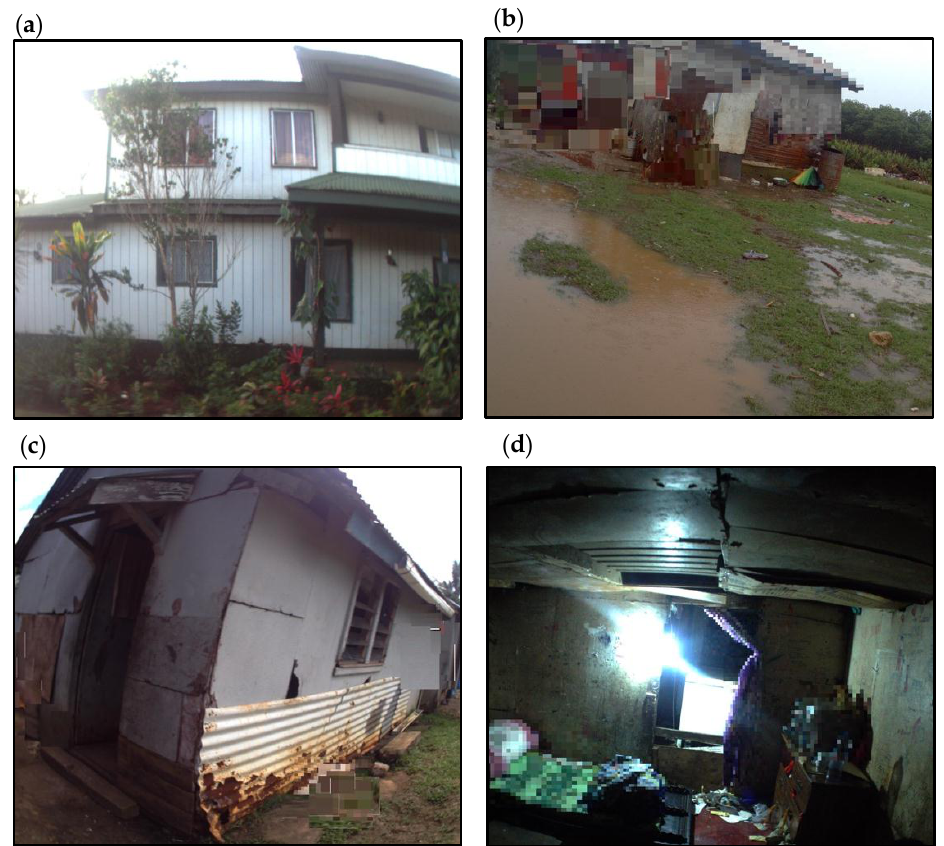
Figure 1. Range of house quality observed: ( a ) House without any evidence of structural damage and exterior is well maintained; ( b ) House surrounded by pools of rain water due to insufficient drainage, interior of house water damaged; ( c ) Poor building quality indicated by holes in the external wall and use of building materials to patch up exterior; ( d ) Children’s bedroom with damaged ceiling and walls, and evidence of water staining on the cardboard covering holes in the ceiling.